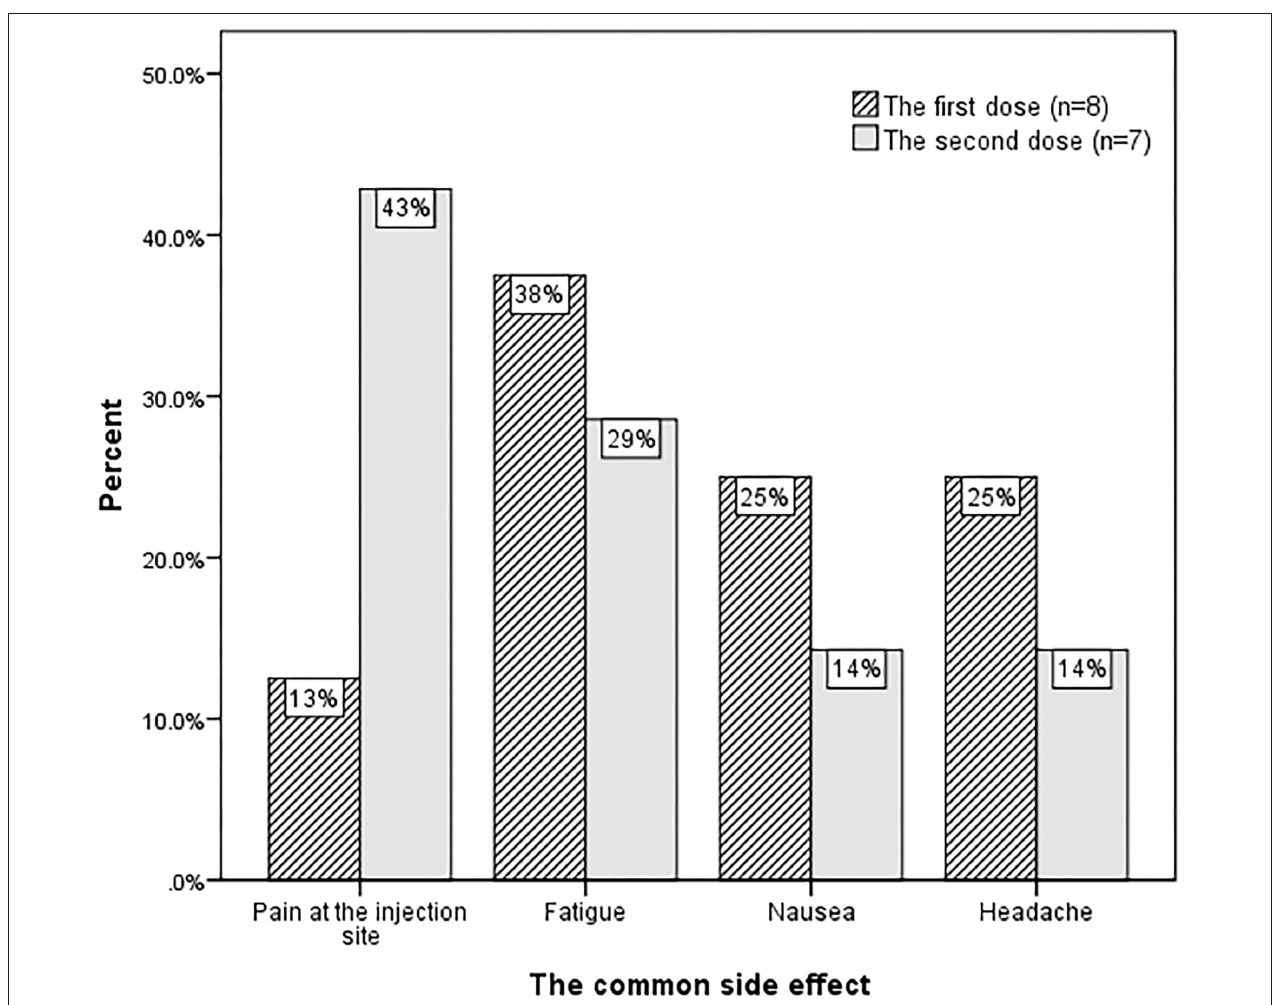
FIGURE 1 | The common side effects of the COVID-19 vaccine in people with